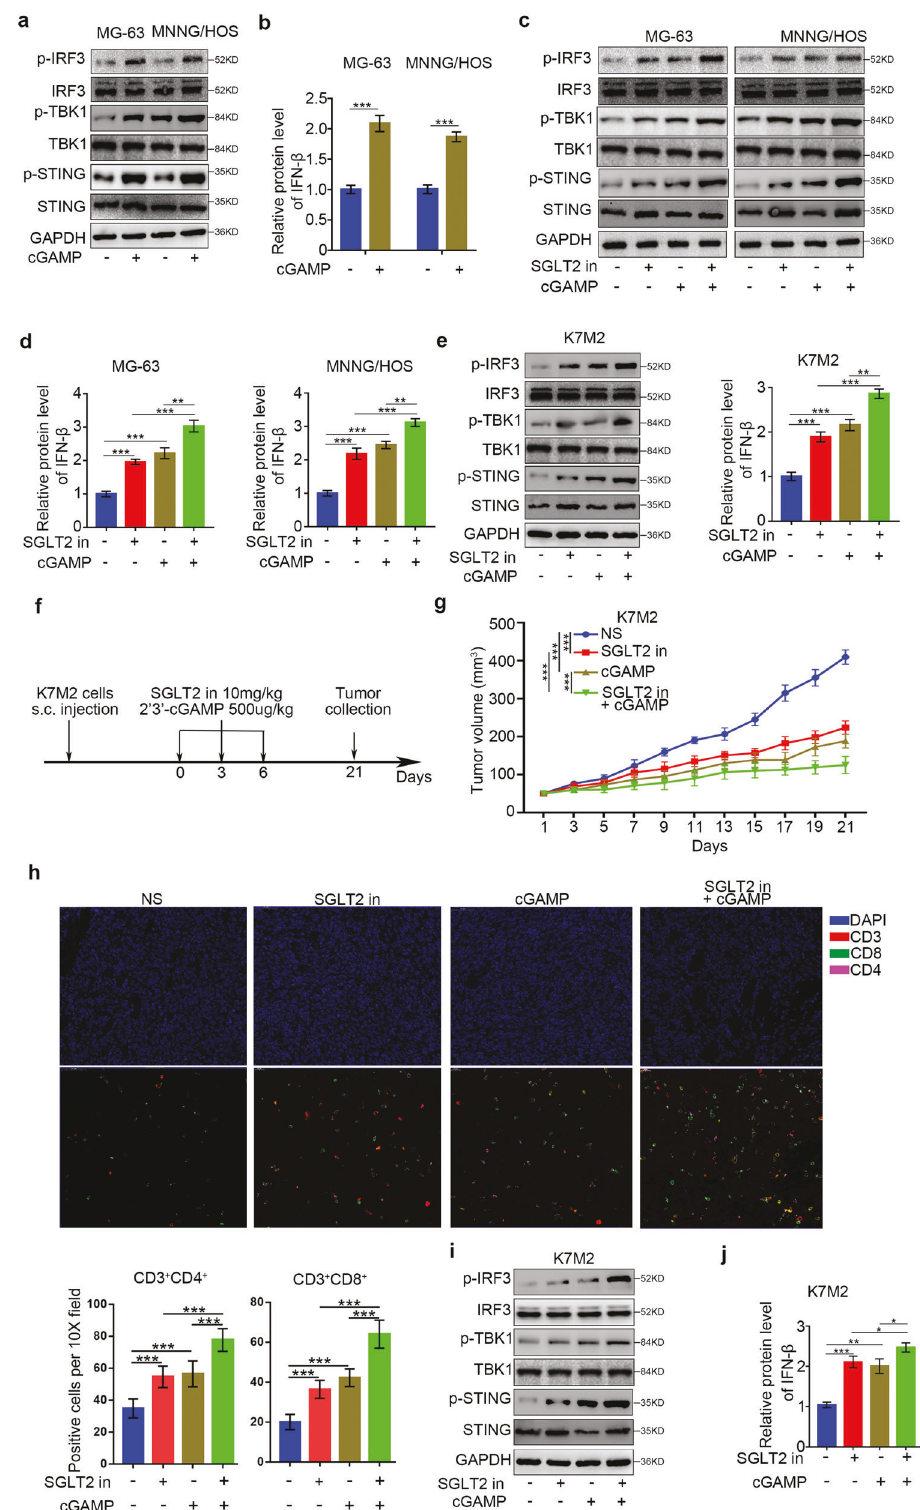
shown that Treatment to elevate STING expression enhances the cancer immunotherapy effect of cGAMP in mice [25]. Having established that the SGLT2 inhibitor activates the STING/IRF3/IFN- β pathway in osteosarcoma cells, we investigated the potential synergistic effects of the STING pathway agonist 2 ’ 3 ’ -cGAMP and Cell Death and Disease (2022)